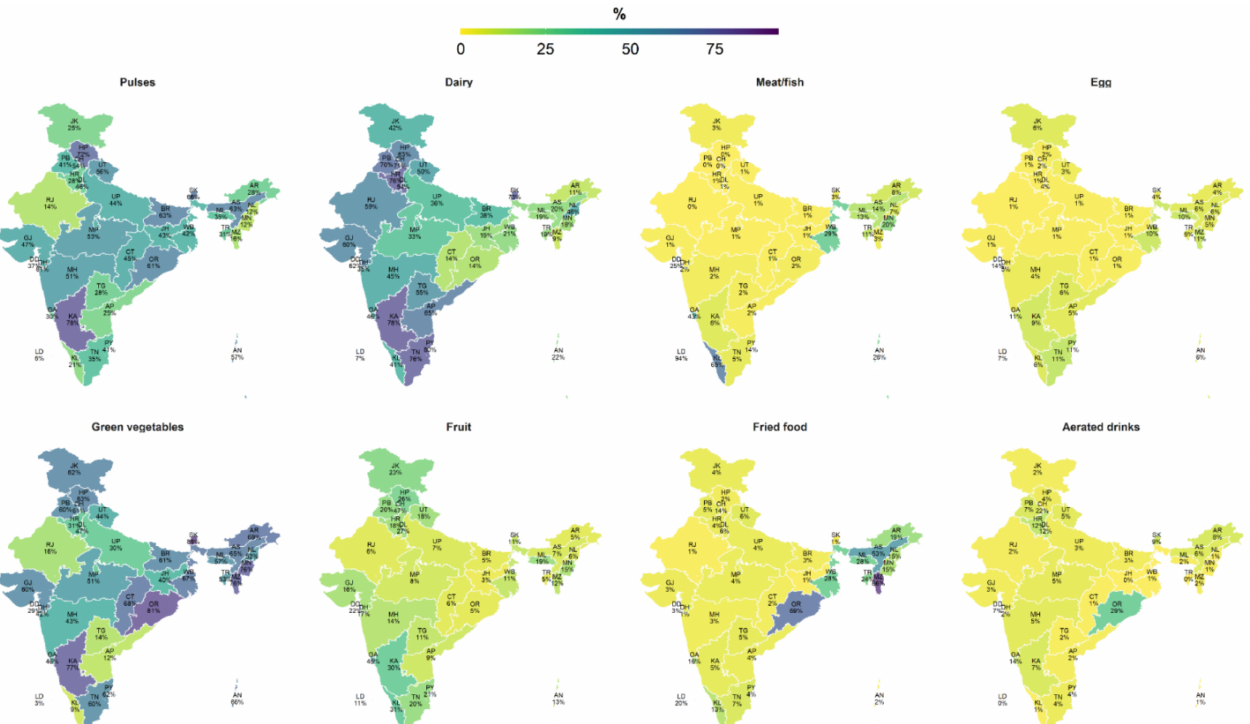
Figure 3. Subnational variation in dietary intake among pregnant women in India 1 . 1 Data comes from the National Family Health Survey in 2015–2016. Values are percentages of women consuming these food groups. AN: Andaman and